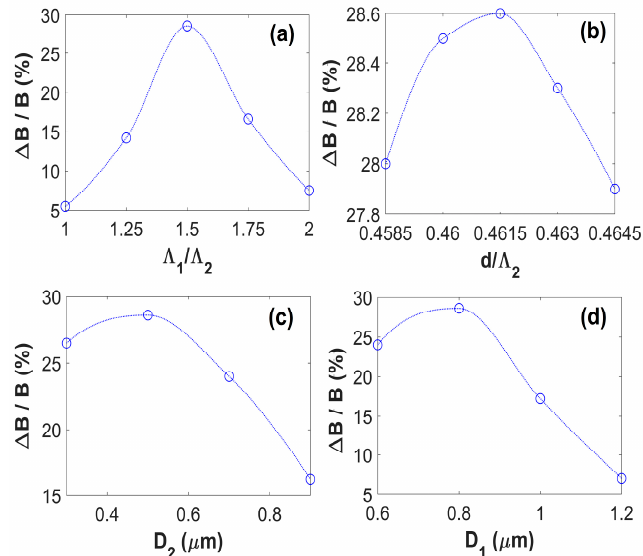
Figure 6. Birefringence sensitivity as a function of di ff erent design parameters: ( a ) hole pitch ratio where d = 1.2 μ m, Ʌ 2 = 3.9 μ m, D 1 = 0.8 μ m, and D 2 = 0.5 μ m; ( b ) hole ratio where Ʌ 1 = 2.6 μ m, Ʌ 2 = 3.9